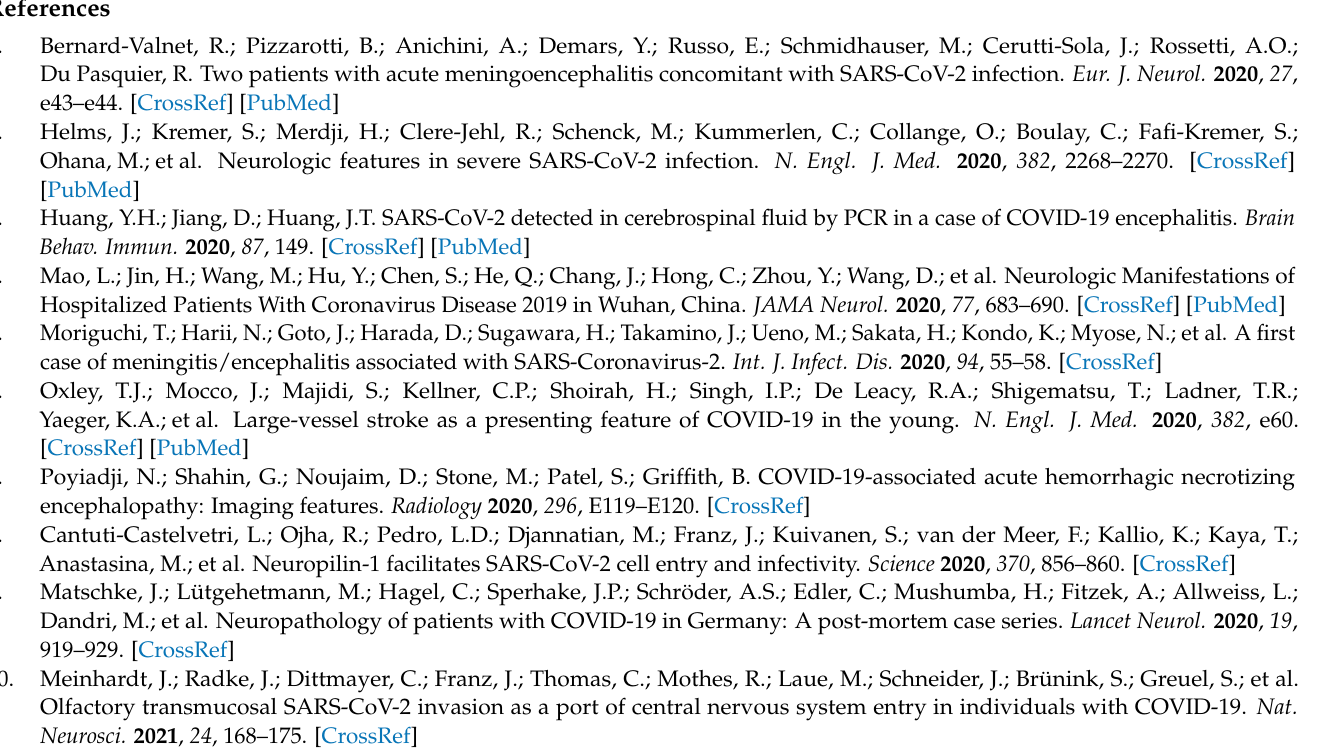
Figure S1: Infection of K18-hACE2 mice with SARS-CoV-2 VOCs leads to substantial weight loss. Figure S2: Infection of K18-hACE2 mice with SARS-CoV-2 VOCs leads to extensive pulmonary infection and spreads to the